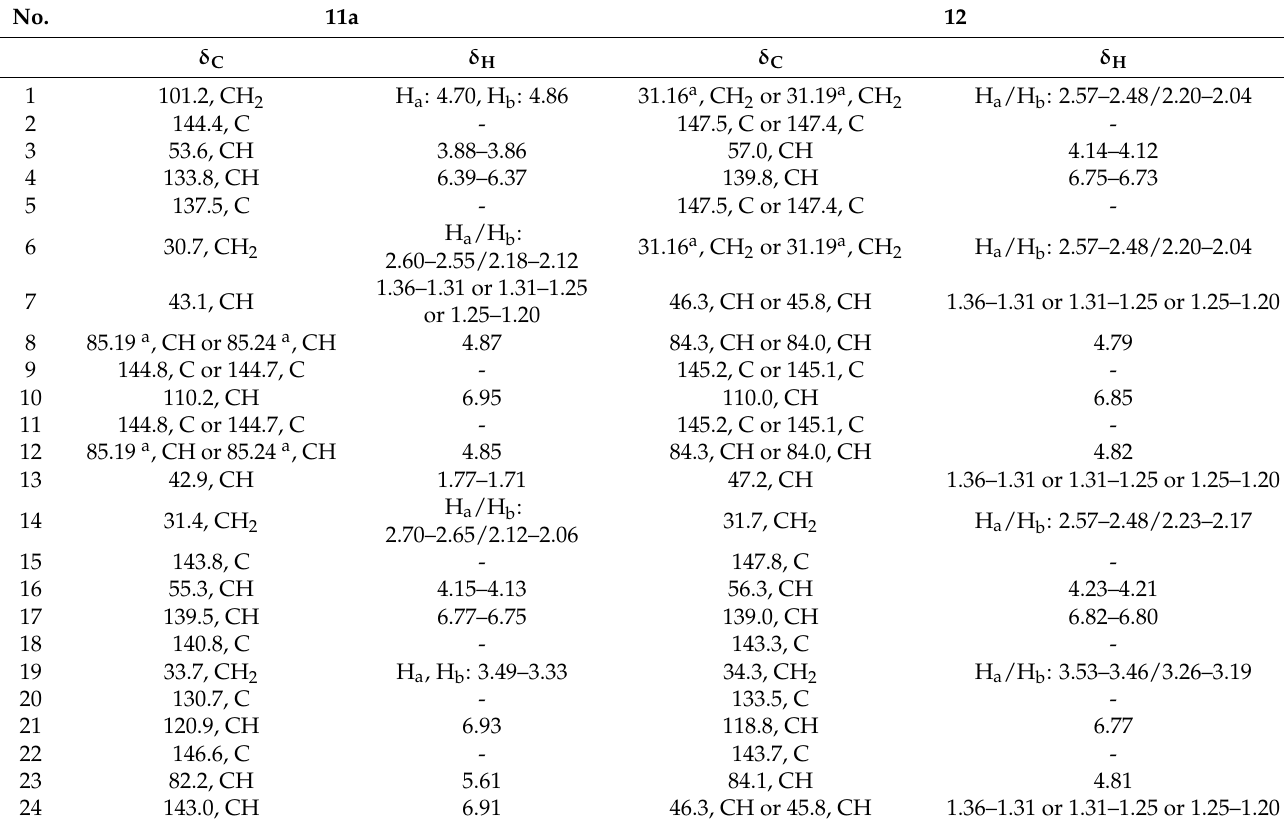
Table 1. 1 H NMR and 13 C NMR (DEPT 135) data for compounds 11a and 12 .